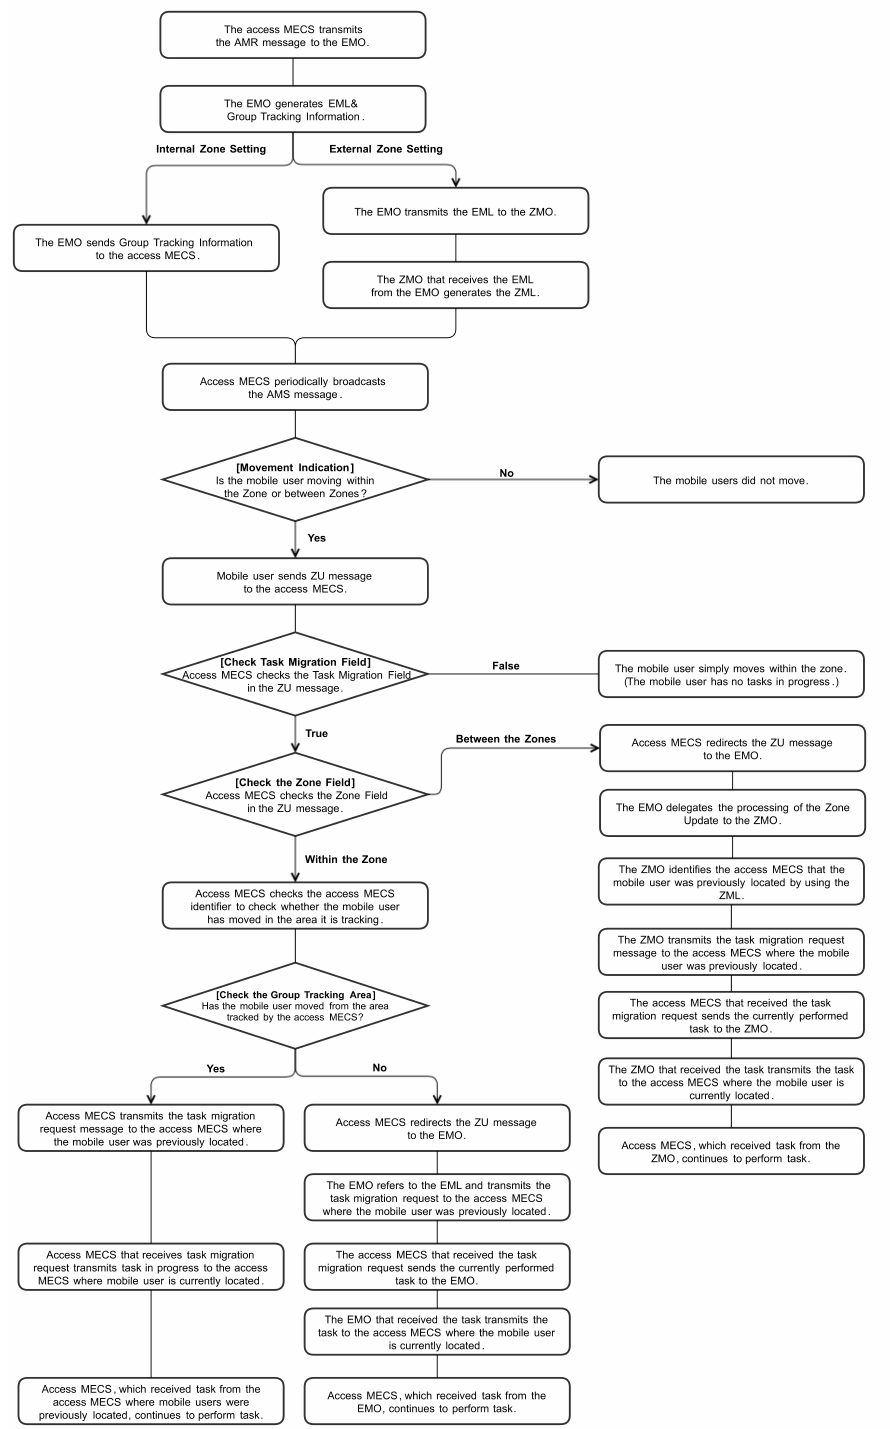
Figure 7. Flowchart of the proposed Zone-based MEC